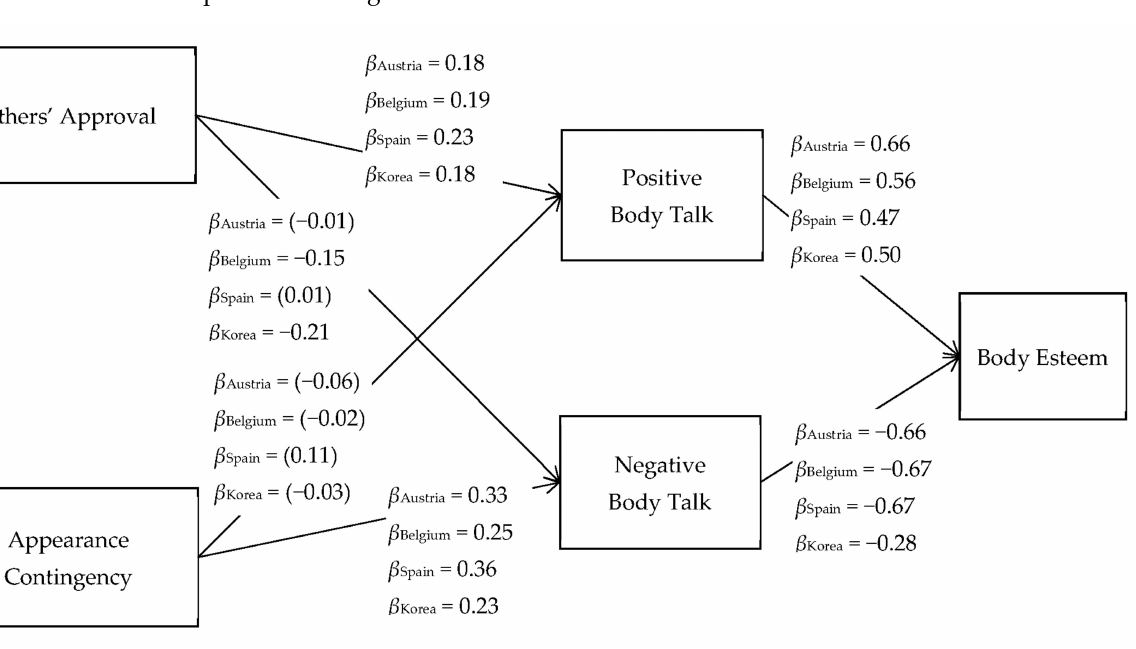
Figure 1. The final model of the relationships between others’ approval, appearance contingency, positive and negative body talk, and body esteem among boys. Note that the values are the observed standardized path coefficients. The path coefficients without parentheses are significant at p <